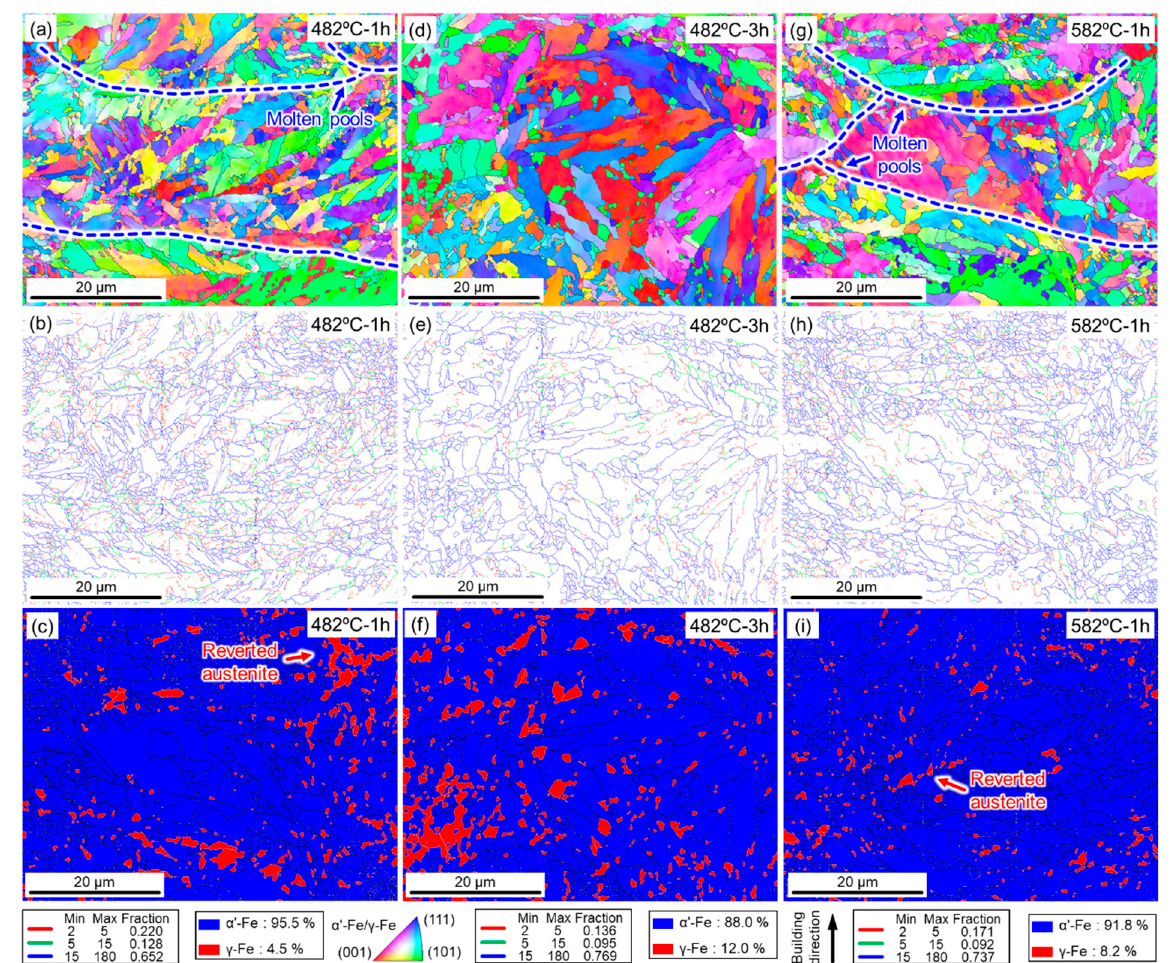
Figure 5. EBSD characterizations of the SLM 17-4 PH steel samples under di ff erent conditions: ( a – c ) aged samples at 482 °C for 1 h; ( d – f ) aged at 482 °C for 3 h; ( g – i ) aged at 582 °C for 1 h. IPF images are shown in the fi rst row, grain boundary distribution in the second row, and phase mapping in the third row.